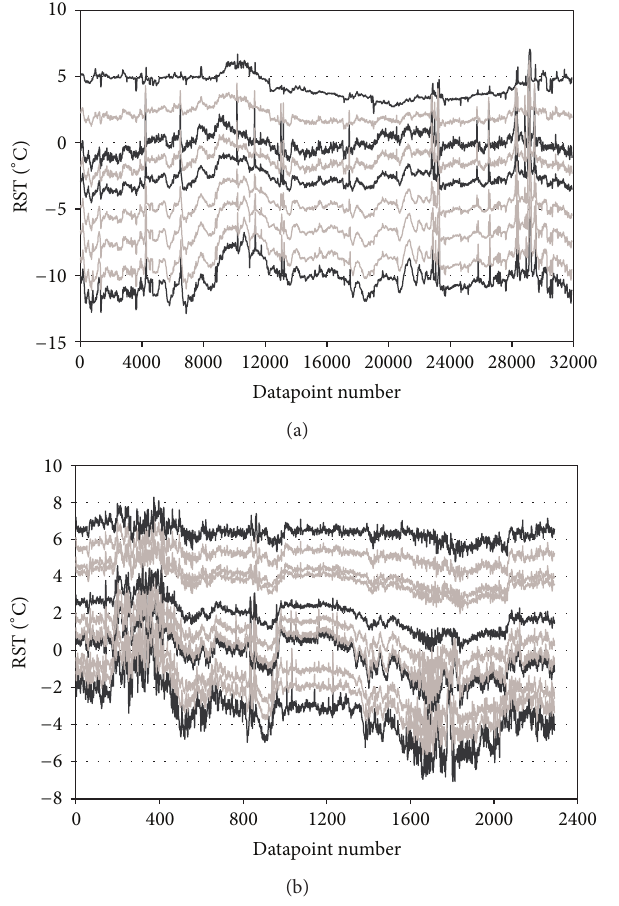
Figure 9: Comparison between ENTICE outputs (solid black lines) and PCA (thin solid grey lines) on UK route (a), and data consistency of the two approaches